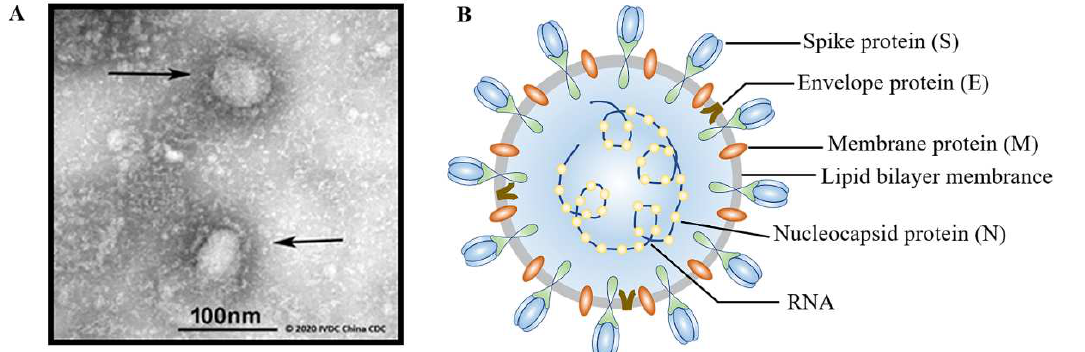
Figure 1. ( A ) Transmission electron microscopy (TEM) image of the COVID-19 virus (courtesy of IVDC, the Chinese Centre for Disease Control & Prevention; source: GISAID, https://www.gisaid.org/ (accessed on 21 October 2021). ( B ) Schematic representation of SARS-CoV-2 virus structure.